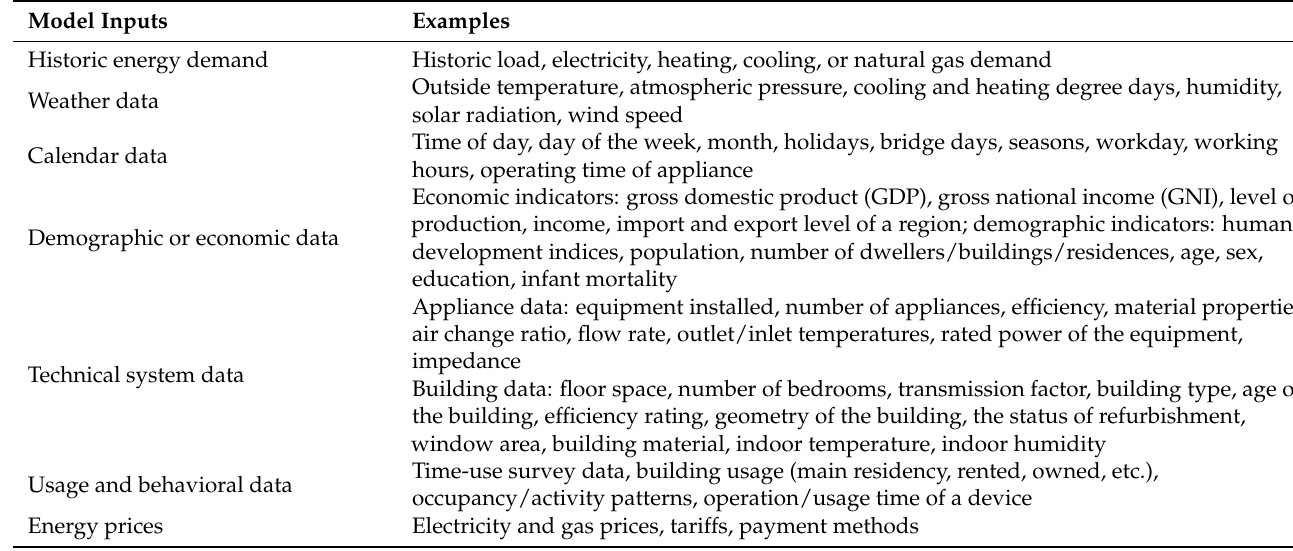
Table 3. Model inputs. Classification of possible data-sets used as model input along with examples of data-sets. Model